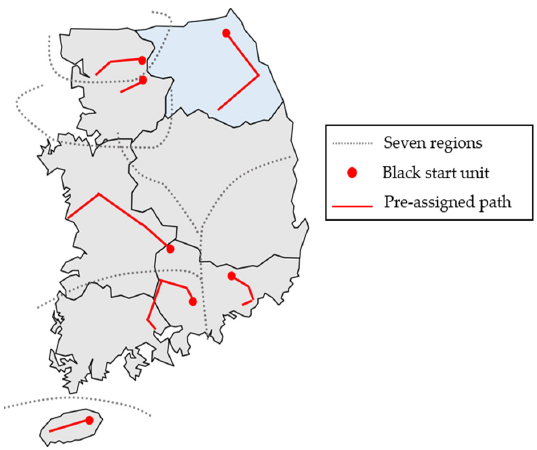
Figure 6. Korean power systems.